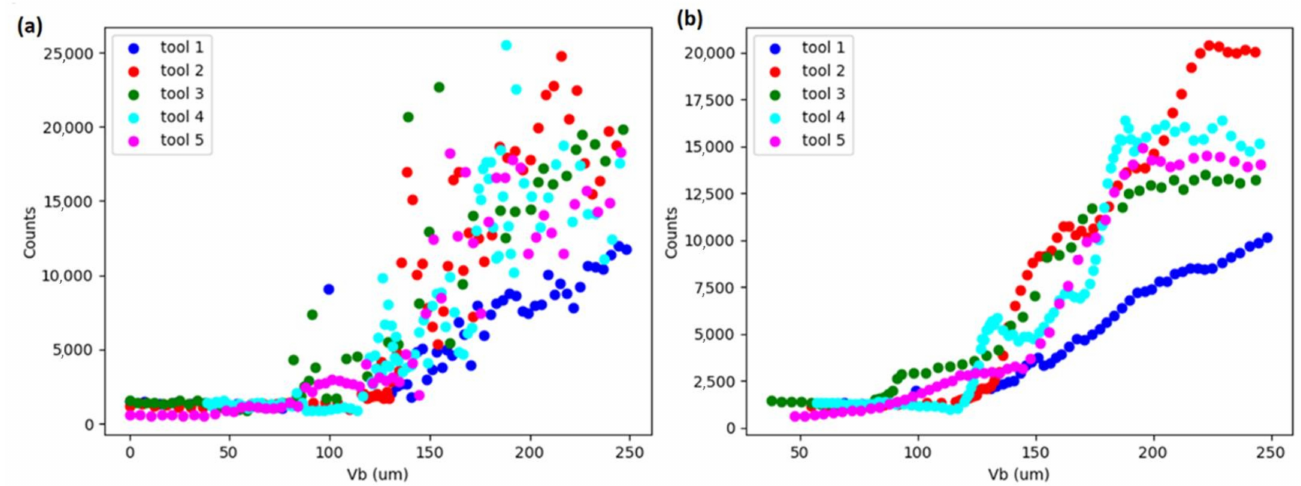
Figure 10. Scatter plot of counts versus flank wear ( a ) original and ( b ) applying moving average filter. The optimum segment size was evaluated for 5 different segment durations, ranging from 0.1 to 2 s. Figure 11 shows the results obtained which shows that the RMSE error decreases from 0.1 to 1 s, increasing afterwards using 2 s segments, with 1 s being the optimum segment size.